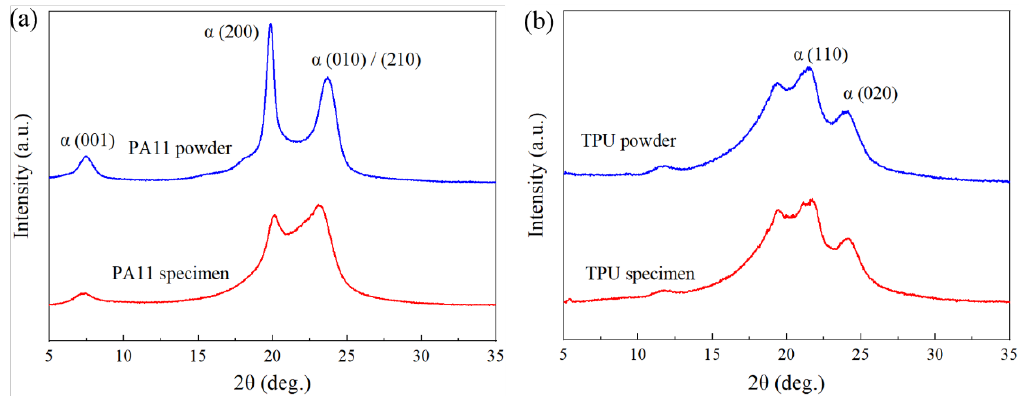
Figure 4. XRD analyses of powder and specimen: ( a ) PA11 and ( b ) TPU.